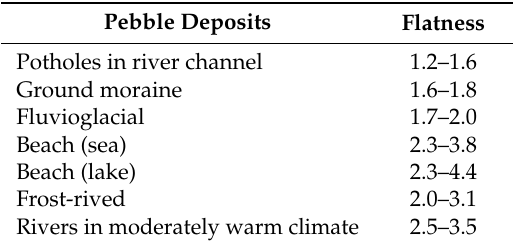
Table 3. Flatness in various sedimentary environments, after [23,24].